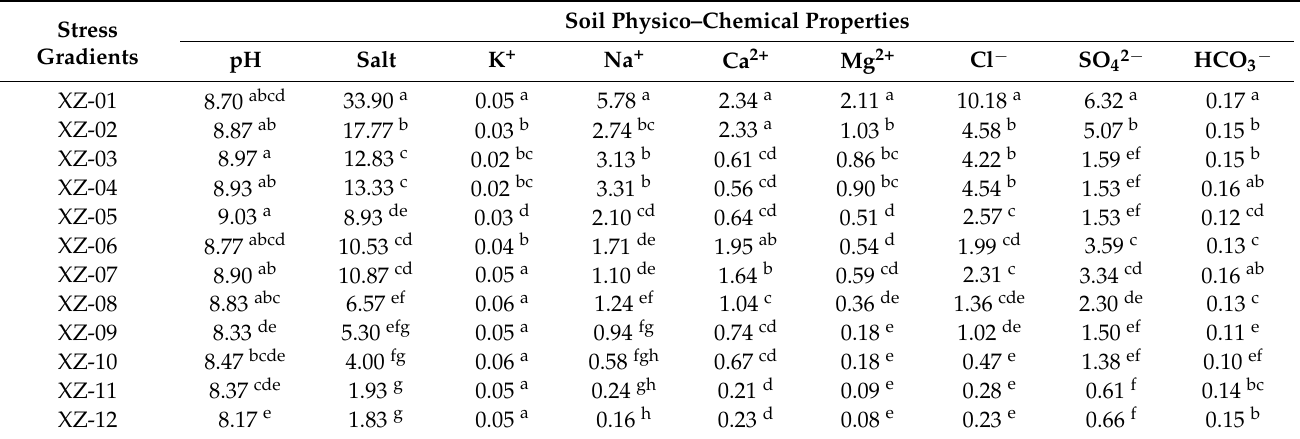
Table 1. Soil physico–chemical properties of the study